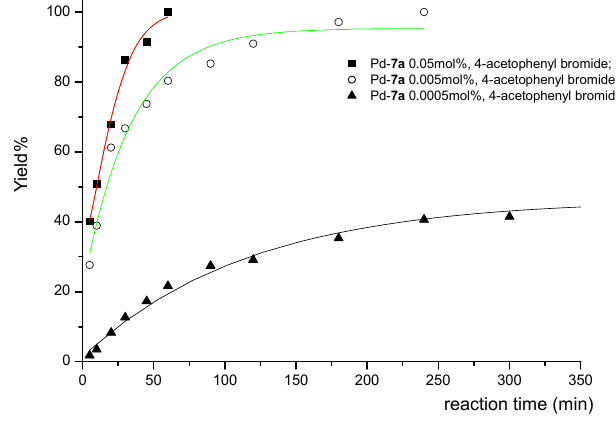
Figure 3. Reaction profiles for Suzuki-Miyaura reaction between 4-acetylphenyl bromide and phenylboronic acid catalyzed by different Pd/ 7a loading: 0.05 mol% ( ■ ), 0.005 mol% ( ○ ), 0.0005 mol% ( ▲